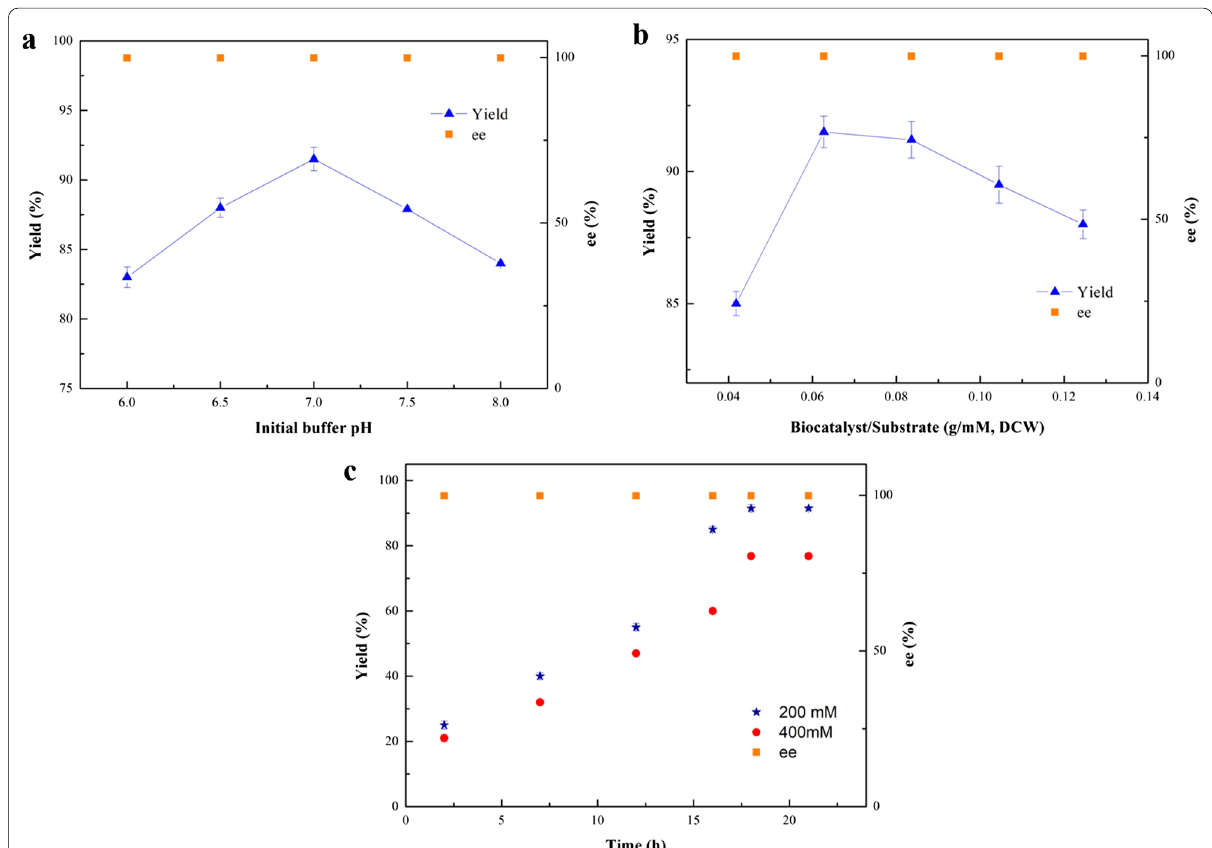
Fig. 5 Effects of key reaction parameters on the ( R )-MTF-PEL production with recombinant E. coli cells in a Tween-20/ChCl:Lys-containing system. Reaction conditions: a Effect of initial buffer pH: 200 mM 3’-(trifluoromethyl)acetophenone, 15% (v/v) isopropanol, 0.6% (w/v) Tween-20, 4% (w/v) ChCl:Lys, 17.2 g (DCW)/L recombinant E. coli cells, 30 ℃ , 200 rpm, 21 h. b Impact of the ratio of biocatalyst/substrate: 200 mM 3’-(trifluoromethyl) acetophenone, 15% (v/v) isopropanol, 0.6% (w/v) Tween-20, 4% (w/v) ChCl:Lys, PBS buffer (pH 7.0), 30 ℃ , 200 rpm, 21 h. c Time course of